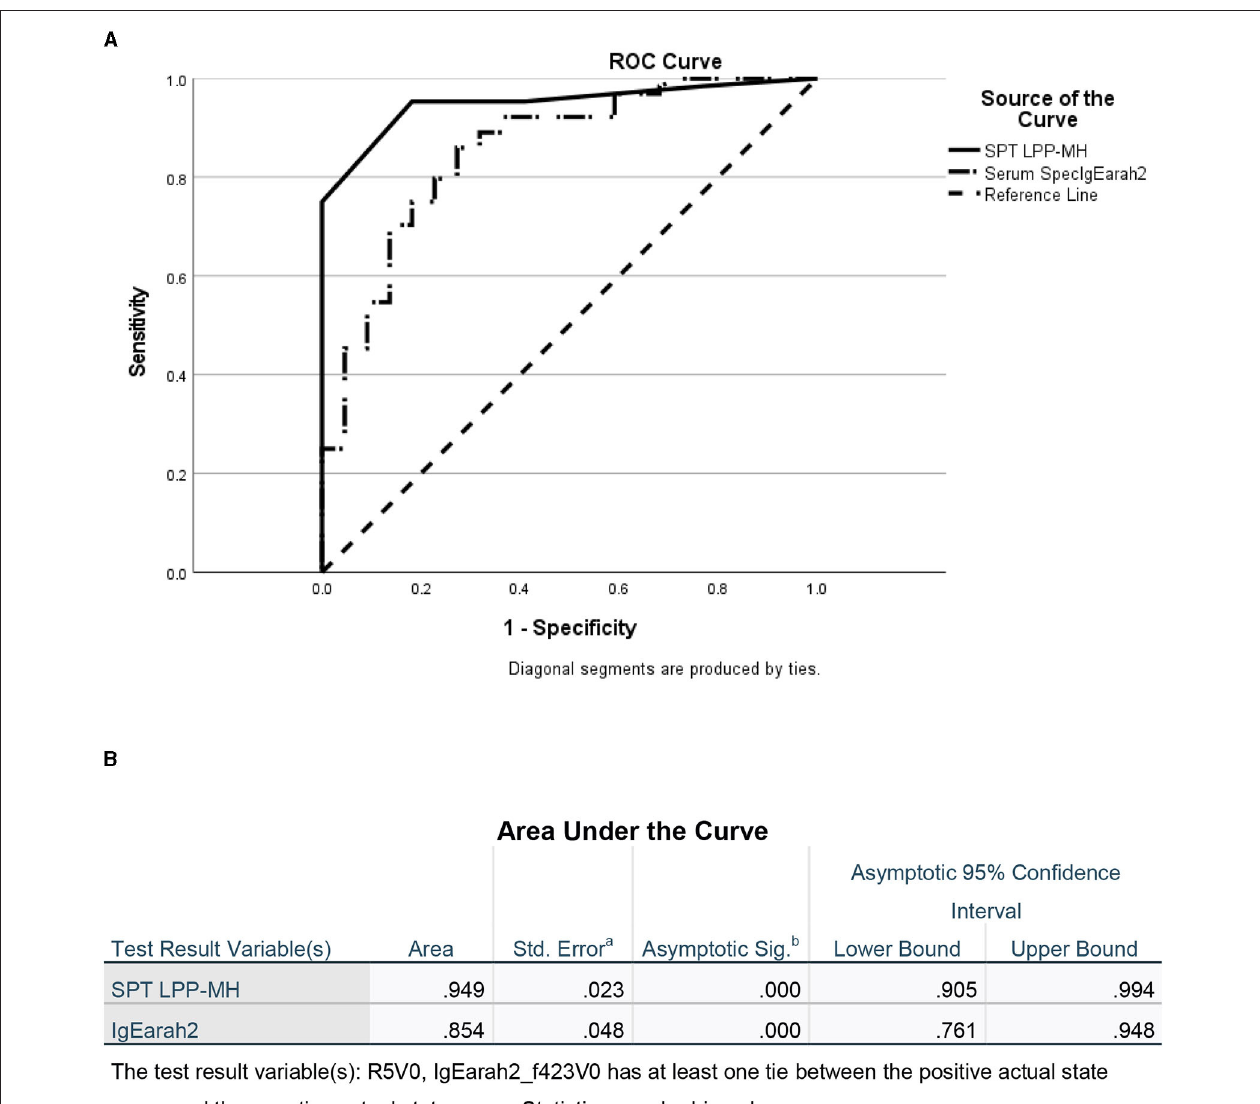
FIGURE 3 | ROC of skin tests with SPT LPP-MH and serum Specific IgE Ara h2 for the diagnosis of Peanut allergy in children. (A) ROC curve and (B) Area under the curve.